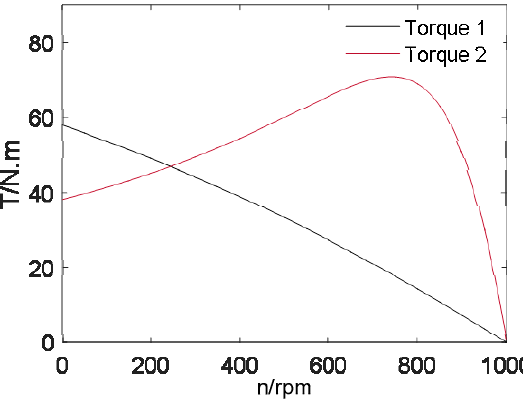
Figure 12. The torque-speed curve.